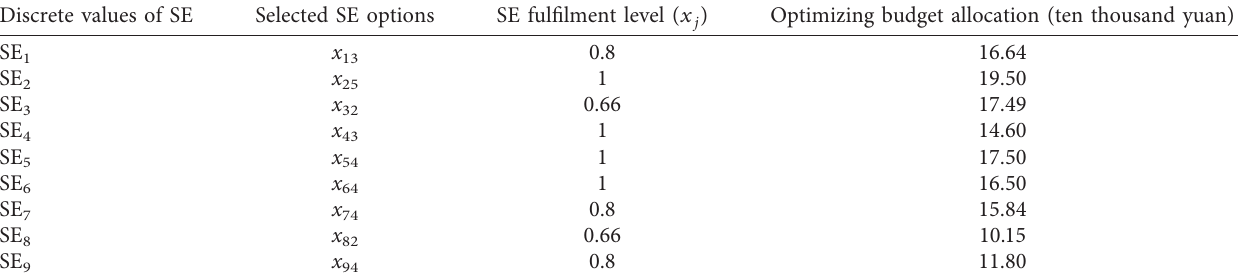
Table 11: Results of SE fulfilment and optimizing budget